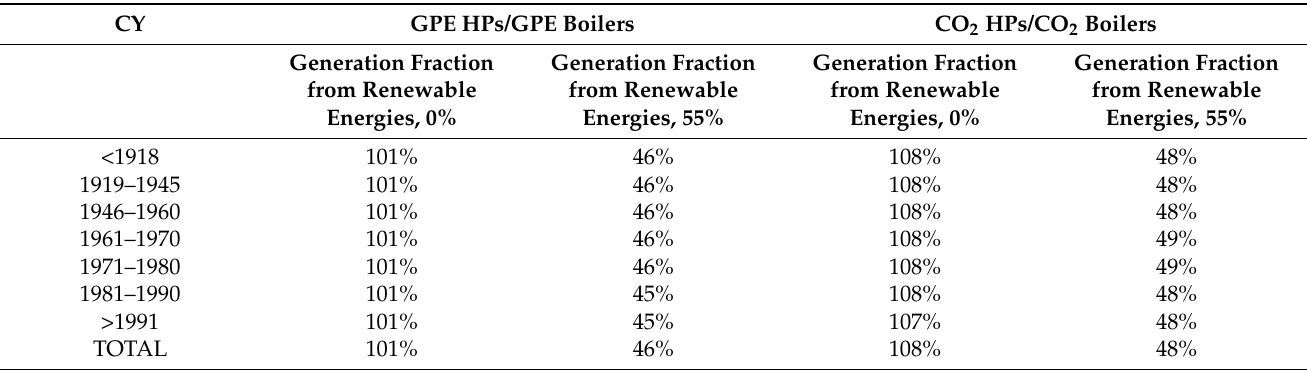
Table 9. Percentage ratio of global primary energy from fossil fuels (GPE) and emissions of CO 2 of heat pumps to that of boilers per building construction year CY in the city of Milano (generation fraction from RES 0% and 55% (2030), grid losses 10%, COP at design temperature of − 5 ◦ C).